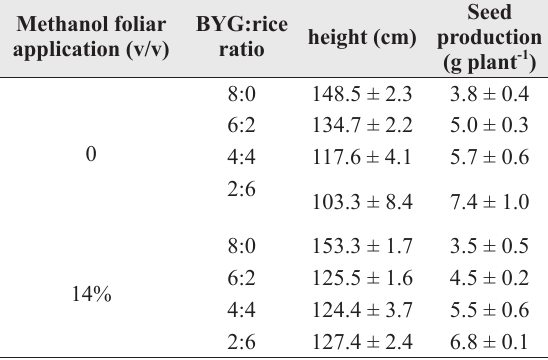
Mean comparison for methanol foliar application × rice:barnyardgrass ratio interaction for barnyardgrass plant height and seed production (averaged across two